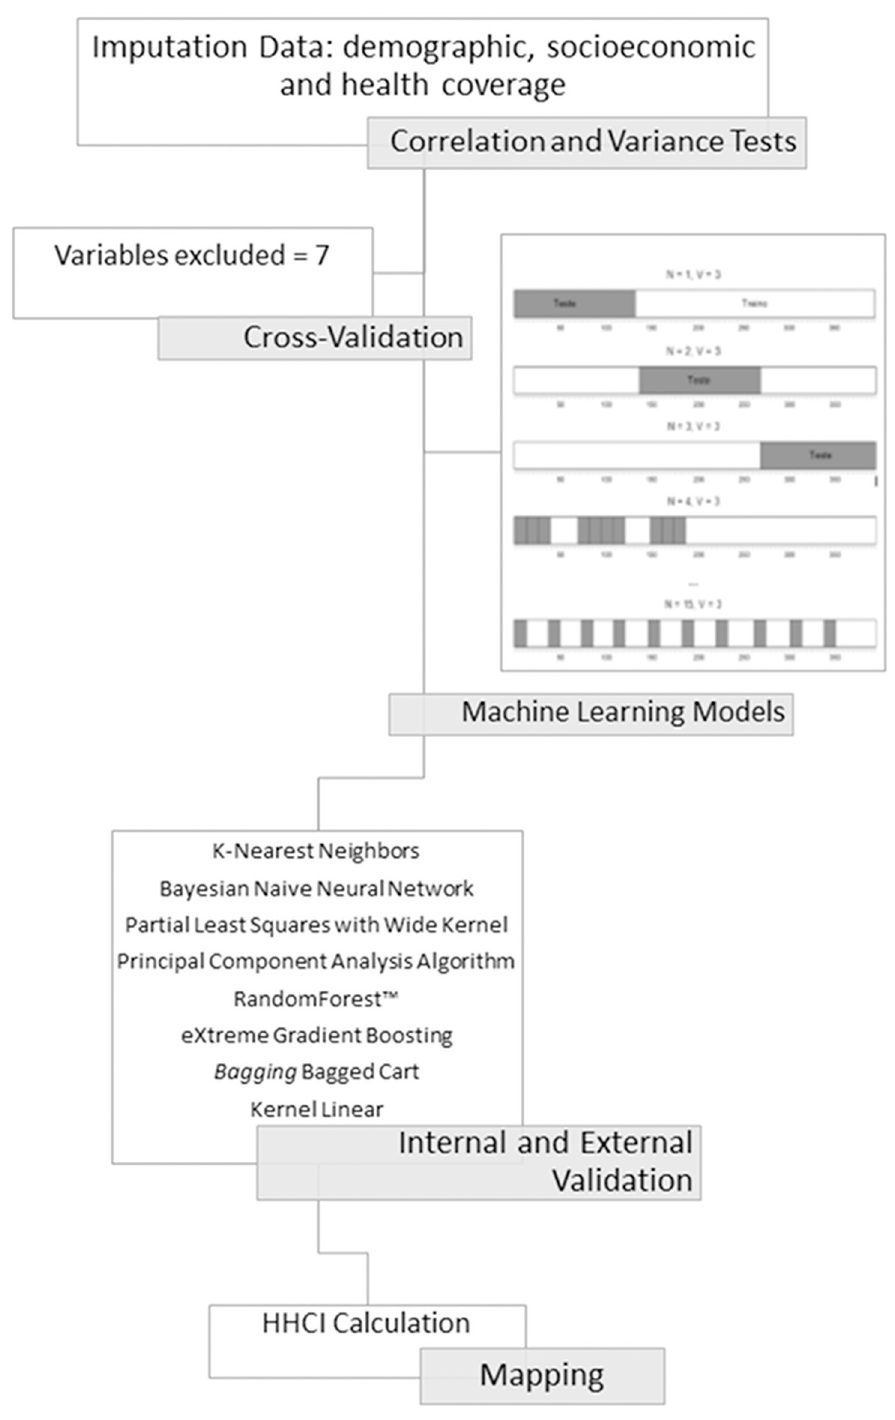
Fig 1. Representative flowchart of the main machine learning model development stages. 1) Variables pre- processing (correlation and variation tests); 2) Predictive variables cross-validation; 3) Machine learning models discrimination and validation (internal and external validation); 4) Heart Health Care Index (HHCI) calculation and mapping.